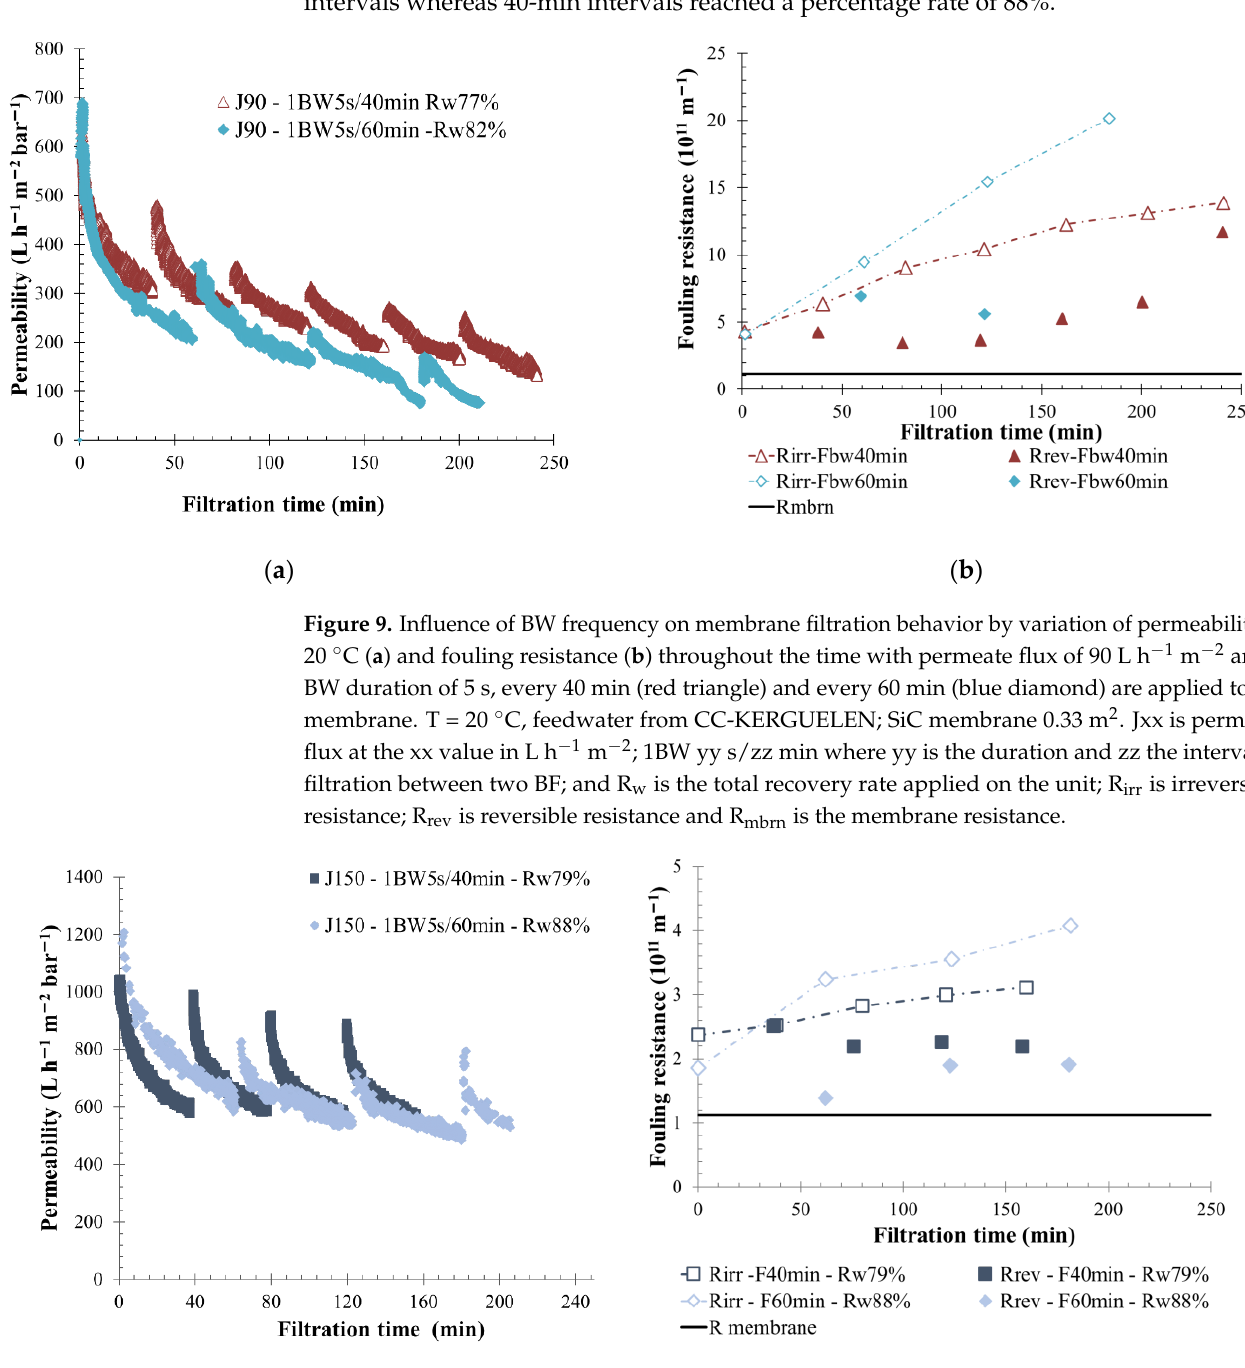
BW interval helps to obtain a higher permeate recovery rate, 10% higher with 60-min intervals whereas 40-min intervals reached a percentage rate of 88%.